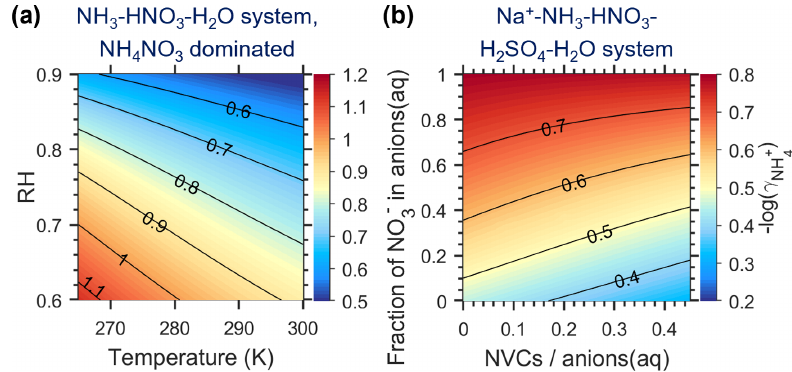
), as estimated by E-AIM. 4